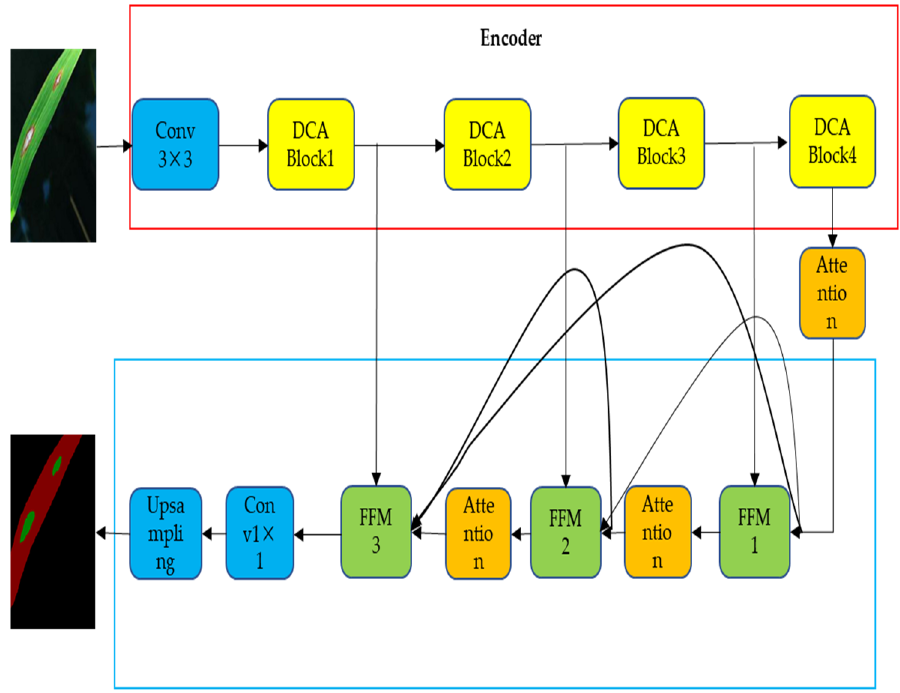
Figure 1. Overall network structure of DFFANet, which is mainly composed of two parts: encoder and decoder.